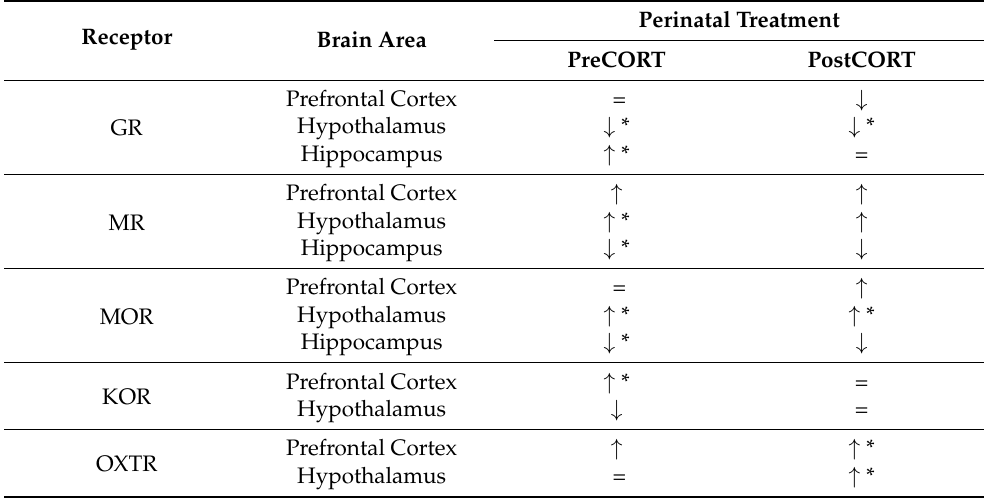
Table 2. Summary of the effects due to perinatal treatment on receptor density among three different areas of interest: prefrontal cortex, hypothalamus and hippocampus. Symbol * indicates a statistically significant increase ( ↑ ) or decrease ( ↓ ) in comparison with AFR